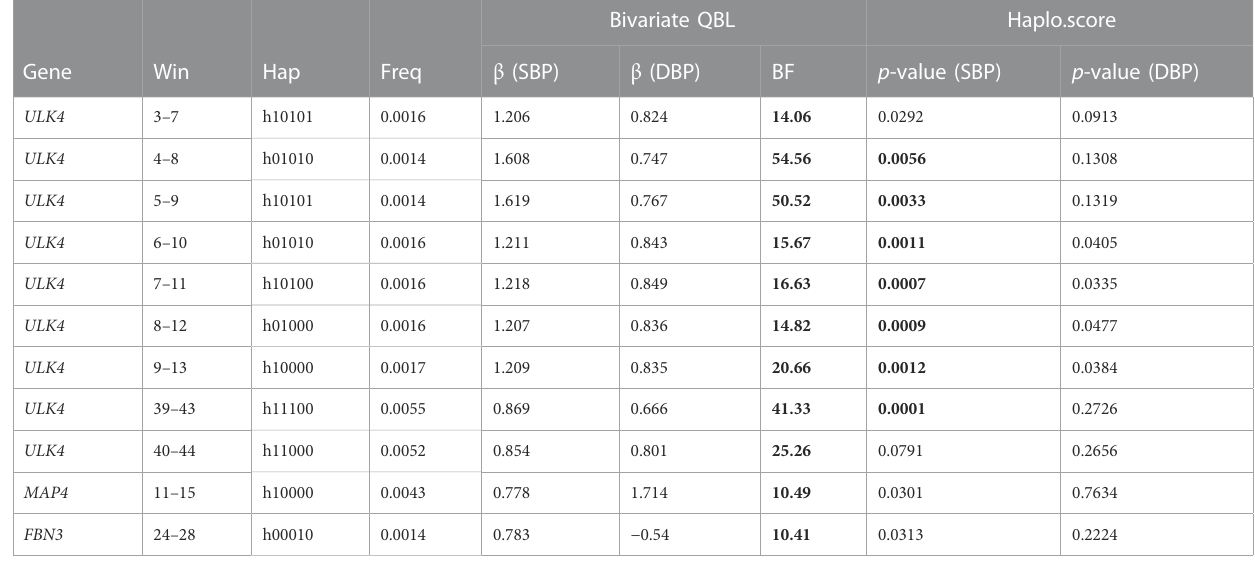
TABLE2Haplotypeblockssigni fi cantatthe2.5%levelon ULK4 , MAP4 ,and FBN3 genesusingthebivariateQBLorHaplo.score(signi fi cantBFor p -valueisshownin boldface). Bivariate QBL